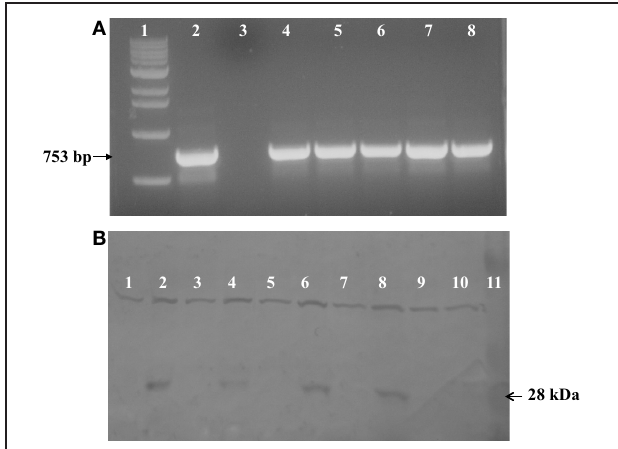
FIGURE 2 | (A) One percent agarose gel stained with ethidum bromide showing PCR analysis results of soybean ferritin DNA detection in transformed maize lines and the non-transformed line B73 used as a negative control. Lanes 1 and 2 refer to 1kb molecular DNA size marker and soybean ferritin plasmid (pMNK01) positive control, respectively. Lane 3 represents the negative control while lanes 4 through 8 represent the transformed maize lines (P344-2-4-1, P344-4-1-6, P344-5-2-1, P344-6-6-1, and P344-7-4-1, respectively). The black arrow shows the specific 753 bp fragment of soybean ferritin coding sequence. (B) Western blot showing the 28kDa soybean ferritin protein band in maize seed endosperms. Lanes 1 through 8 represents transformed maize seeds that were PCR, negative (lanes 1, 3, 5, and 7) or PCR positive (lanes 2, 4, 6, and 8) for the soybean ferritin transgene. Each positive/negative pair of lanes are from a different transformation event (P344-2-4-1, P344-4-1-6, P344-5-2-1, and P344-6-6-1). Lanes 1 and 3 are from event P344-2-4-1; lanes 3 and 4 are from event, P344-4-1-6; lanes 5 and 6 are from event P344-5-2-1 and lanes 7 and 8 are from event P344-6-6-1. Lanes 9 and 10 non-transgenic A188 and B73 seeds that were used as negative controls, respectively, while lane 11 contains the protein molecular size